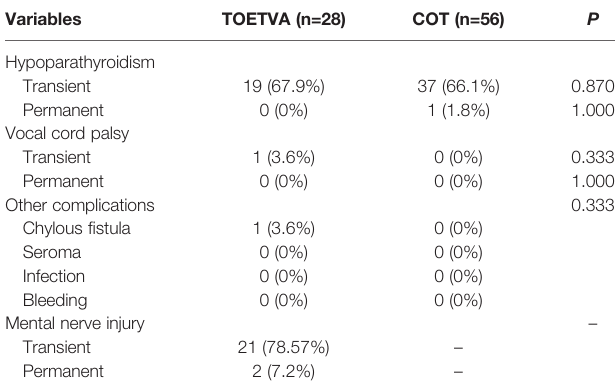
TABLE 3 | Postoperative complications